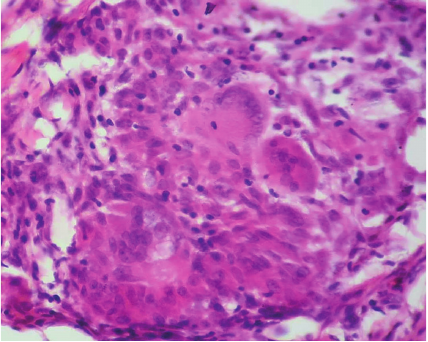
Figure 3: Granuloma showing peripheral lymphocytes, central histiocytes, and giant cell (H&E 40x).